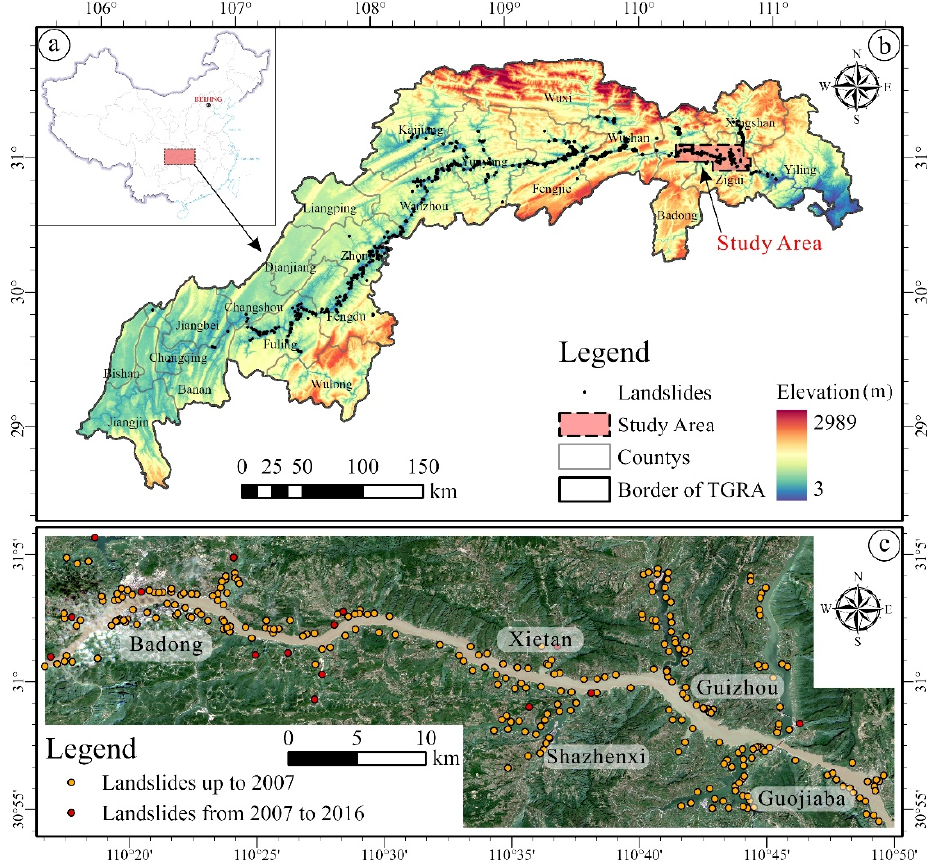
Figure 2. Location of the study area and landslide distribution. ( a ) Location of the TGRA in China. The base map is sourced from http://bzdt.ch.mnr.gov.cn/ (accessed on 12 January 2022). ( b ) Location of the study area and the landslide distribution in the TGRA. The DEM is sourced from https://search.asf.alaska.edu/ (accessed on 15 January 2022). ( c ) Landslide distribution in and Sentinel-2B image of the study area. The Sentinel-2B image was taken on 12 September 2021.